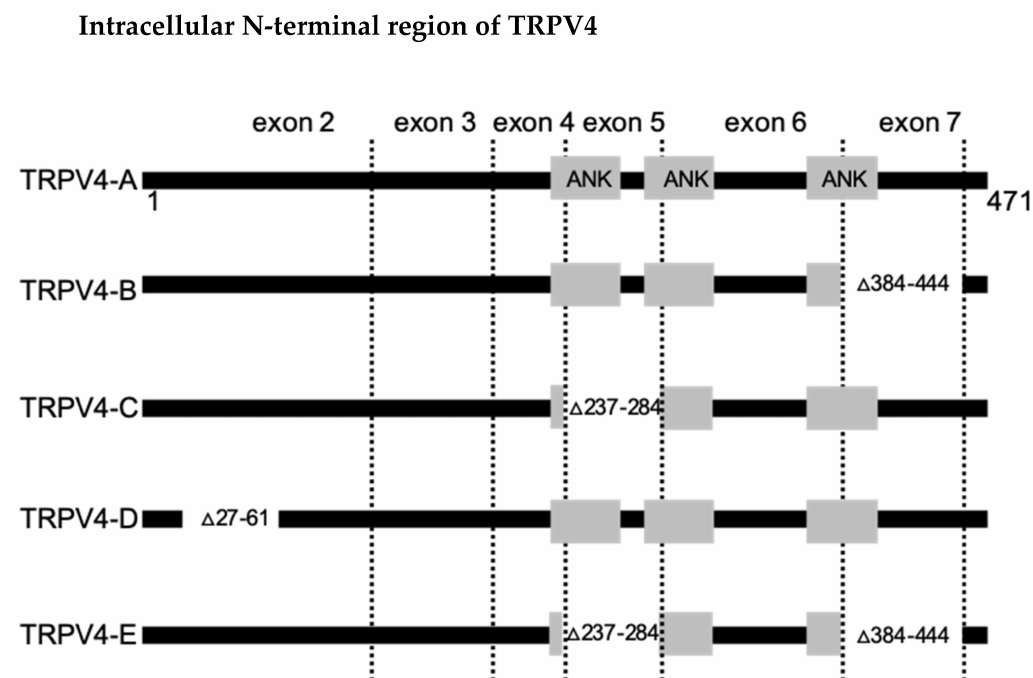
Figure 2. Identifications of (human) TRPV4 splice variants. Intracellular N-terminal region of the human TRPV4 channel (amino acids 1–471). Amino acids and exons lost in each variant are indicated by numbers. From [45] with